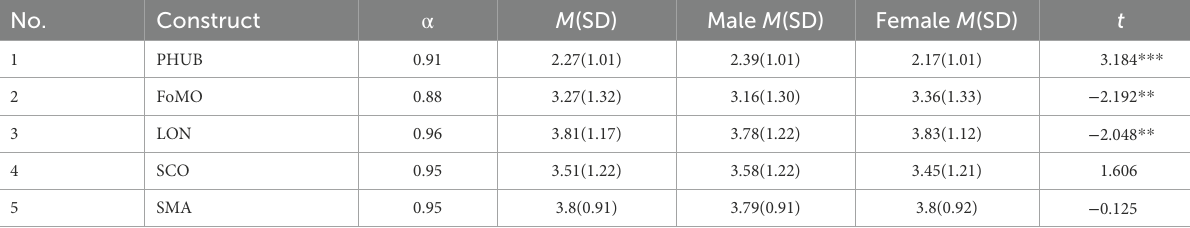
TABLE 1 Comparative descriptive statistics of the main variables affecting students of both genders.